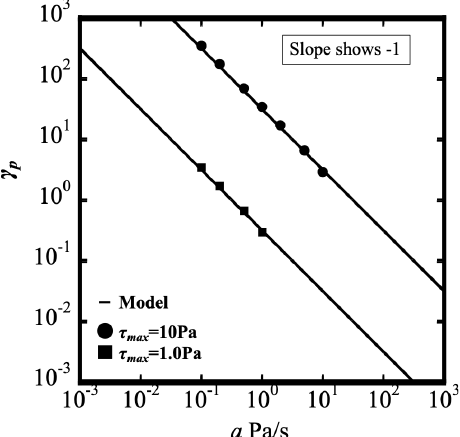
Figure 4: Permanent strain of silicone oil as a function of the stress- ramp rate in the logarithmic scale. The slope of this function is − 1, which is independent of the external conditions as the sample is a Newtonian fluid